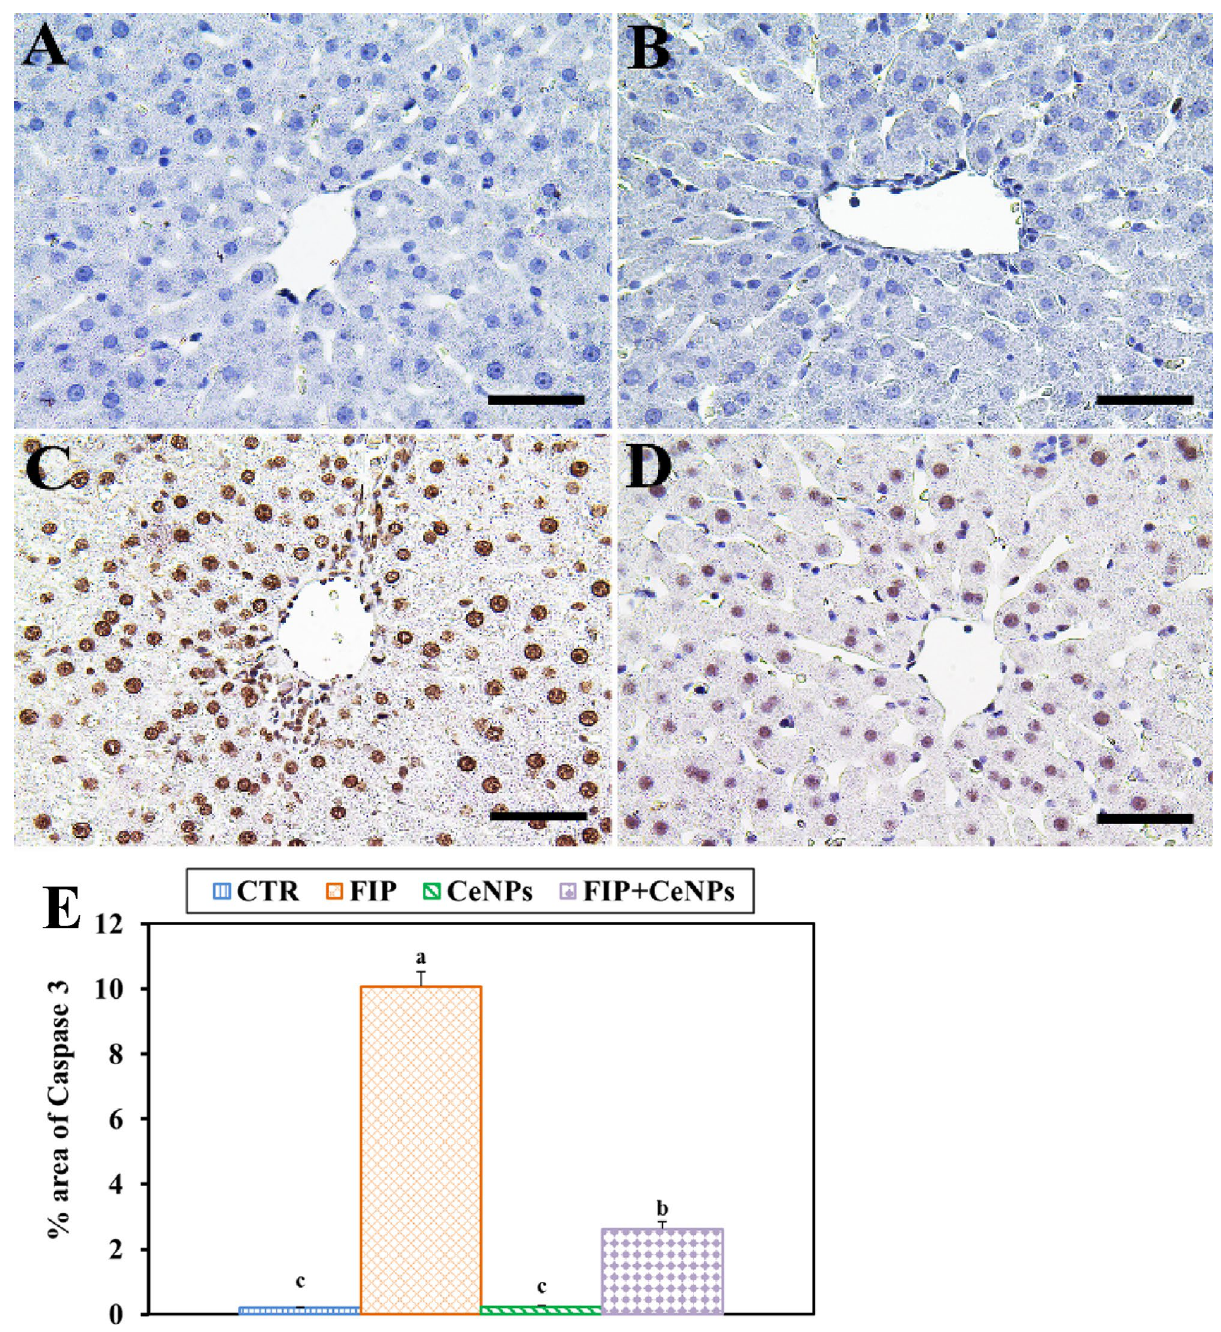
Figure 3. Immunohistochemical staining of rat liver by Caspase3. ( A ) Negative control group. ( B ) CeNPs group. ( C ) FIP group. ( D ) FIP group that treated with CeNPs. Scale bar = 50 µm. ( E ) Quantification of Caspase3 in the hepatic tissues in different groups. Data expressed as Mean ± SE, analyzed using one-way ANOVA at P ≤ 0.05, column with different letters (a, b & c) indicate significant difference among the values of different